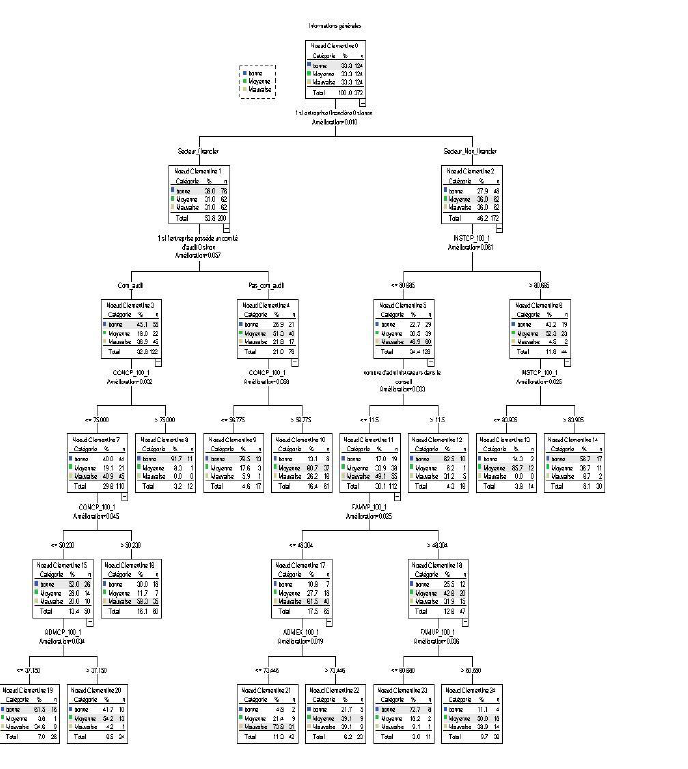
Figure II – Decision tree: General Information on the